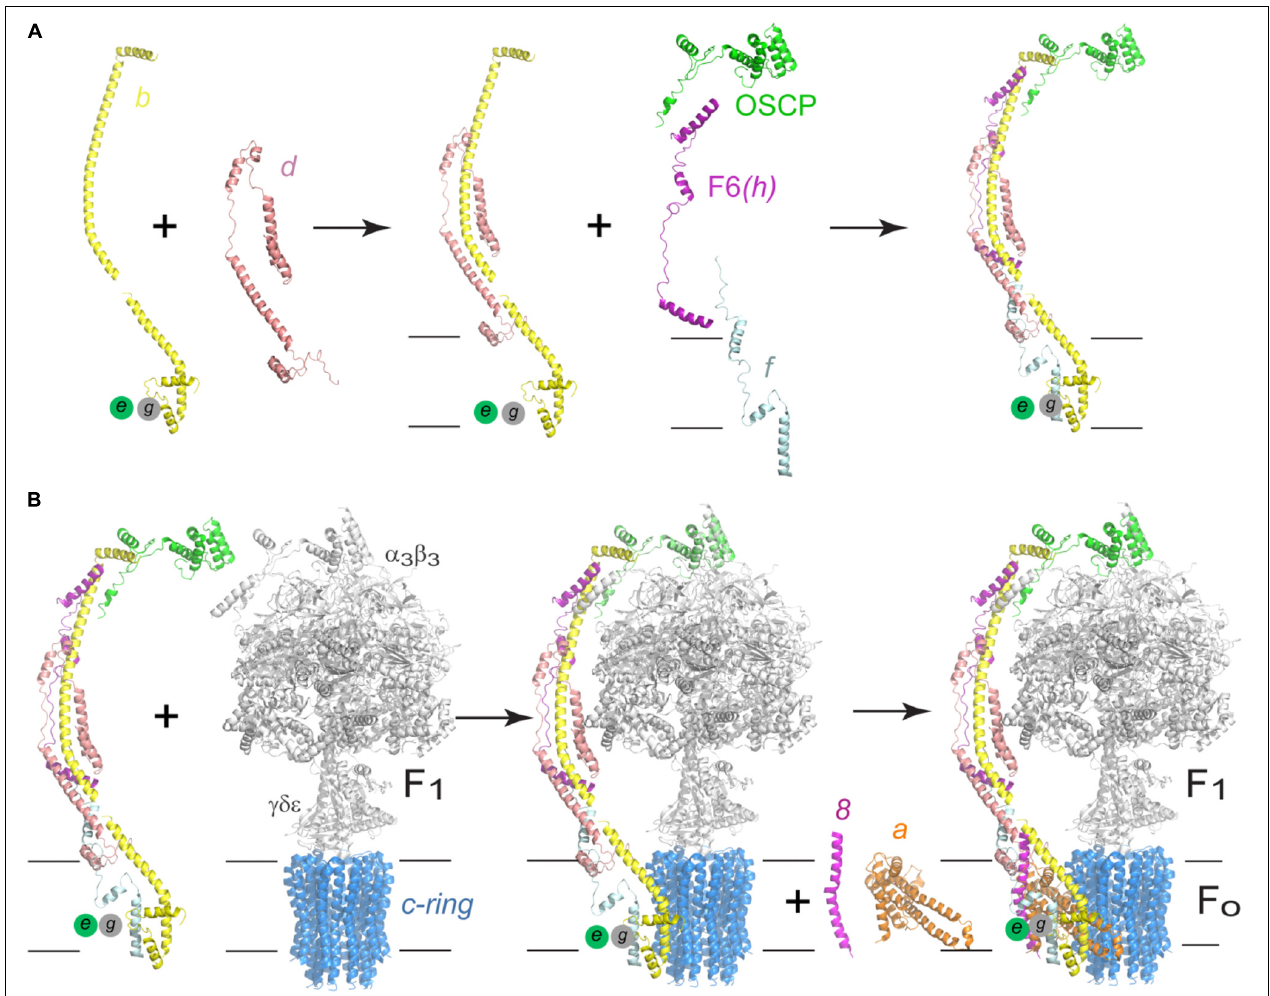
FIGURE 8 | Assembly process of the human F-ATPase. (A) A possible assembly pathway of the peripheral stalk based on the data of Fujikawa et al. (2015) and He et al. (2018). (B) One of the possible assembly pathways of the complete enzyme. According to the branched model proposed by He et al. (2018) and Song et al. (2018), another possibility involves an initial b - d -F6-OSCP subcomplex that first joins F 1 - c -ring after which subunits f , e, and g recruited. The model used in A,B corresponds to the yeast enzyme, PDB 6CP6 from He et al. (2018). The black horizontal lines indicate the mitochondrial inner